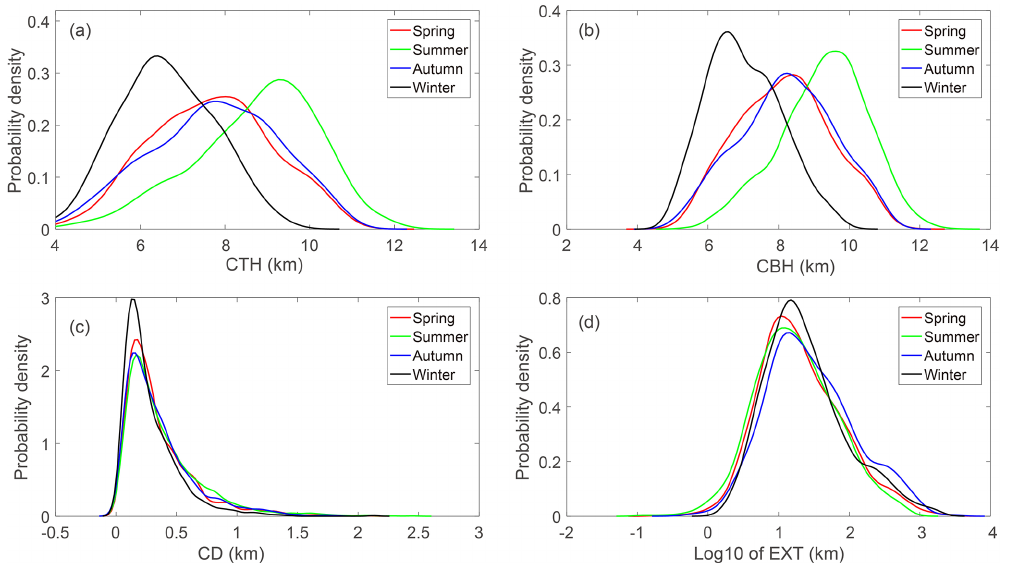
Figure 3. Distribution of cloud-top height (a) , cloud-base height (b) , cloud depth (c) and horizontal extent (EXT; d ) in the four seasons. In panel (d) , EXT is shown as log10